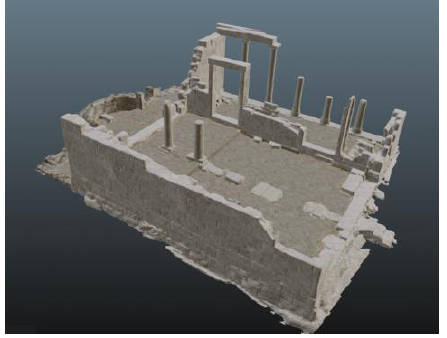
Figure 3: Temple of Demeter